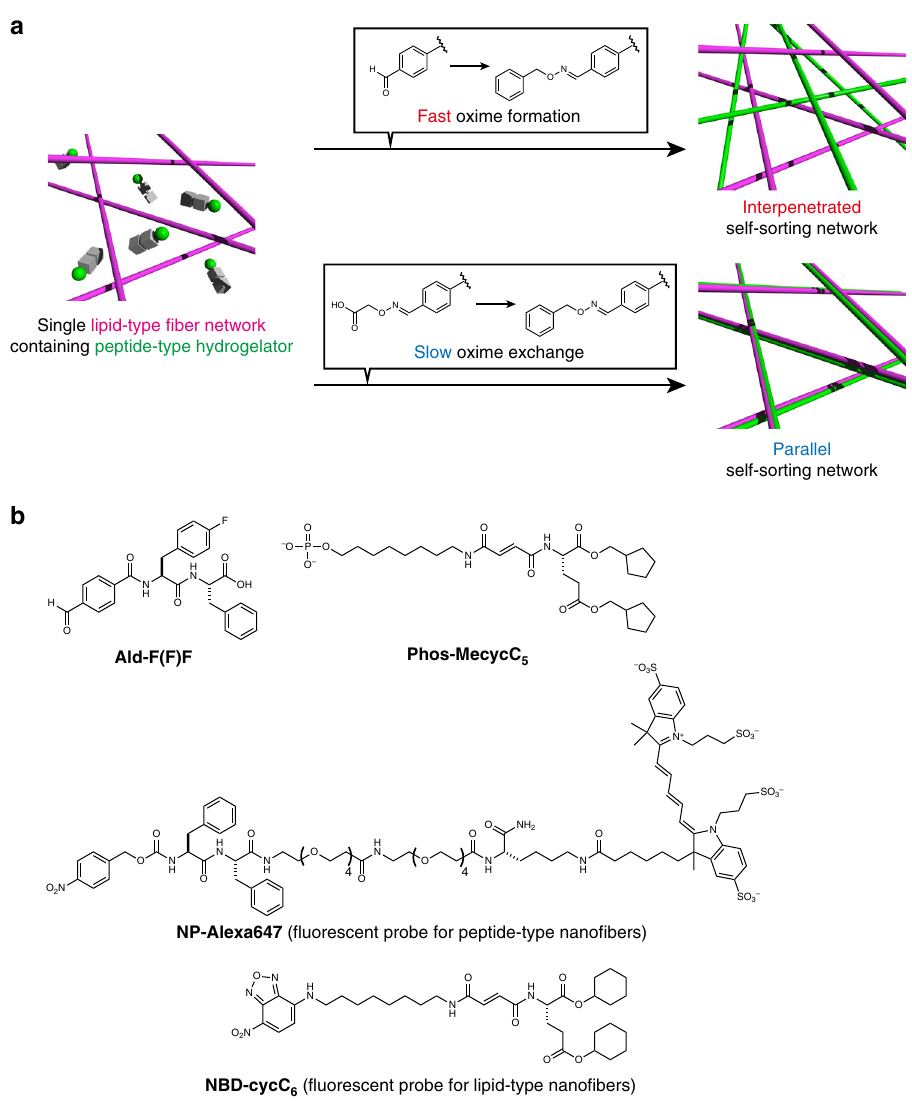
Fig. 1 Selective formation of interpenetrated and parallel self-sorting networks by dynamic covalent oxime chemistry. a Schematic illustration of the formation of two distinct network patterns of self-sorted nano fi bers by dynamic covalent oxime chemistry. b Chemical structures of peptide-, lipid-type hydrogelators ( Ald-F(F)F and Phos-MecycC 5 , respectively), and fl uorescent probes ( NP-Alexa647 for peptide-type nano fi bers and NBD-cycC 6 for